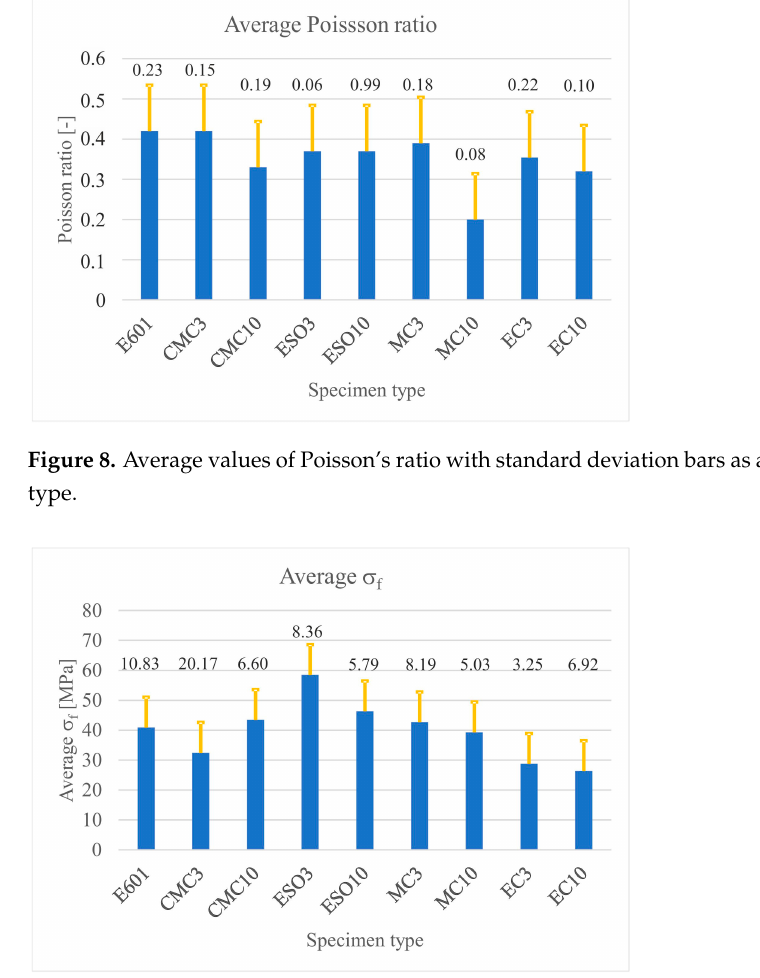
Figure 9. Average values of failure stress with standard deviation bars as a function of the specimen type.